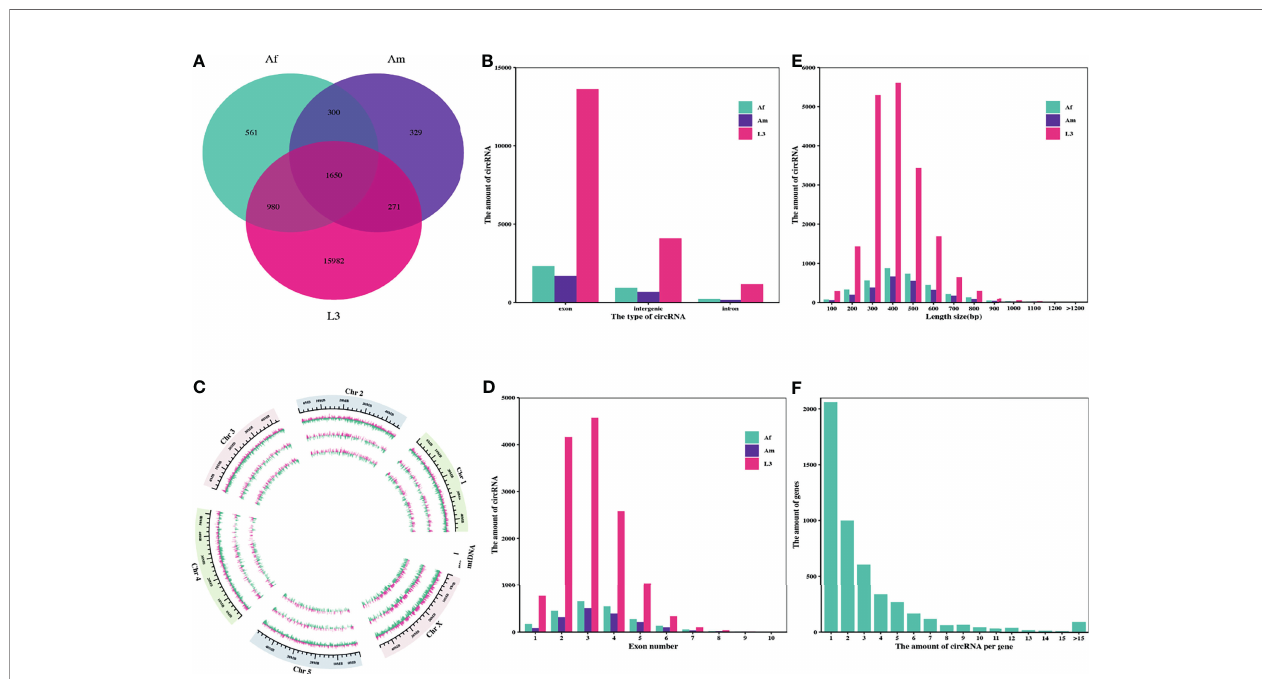
FIGURE 1 | Characteristics of the identi fi ed circRNAs in H. contortus . (A) Venn diagram presenting the amount of circRNAs in third-stage larvae (L3), adult female worms (Af), and adult male worms (Am). (B) The numbers of circRNAs derived from exonic, intronic, and intergenic regions in L3, Af, and Am, respectively. (C) Circos plot showing the distribution of circRNAs on six H . contoruts chromosomes. Light pink bar represented circRNAs from plus strand; pale green bar from negative strand. Each track from the periphery to the core represents: chromosomes; L3; Af; Am. (D) Distribution of amount of circRNAs derived from different number of exons. (E) Length range distribution of the identi fi ed circRNAs. (F) The number of circRNAs per